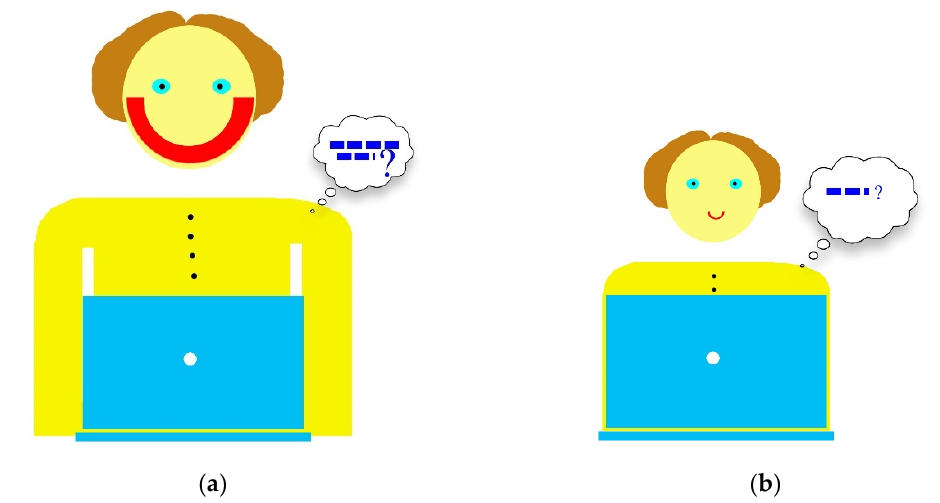
Figure 3. Examples of visual representation of the features of groups with the longest ( a ) and shortest ( b ) average message size.